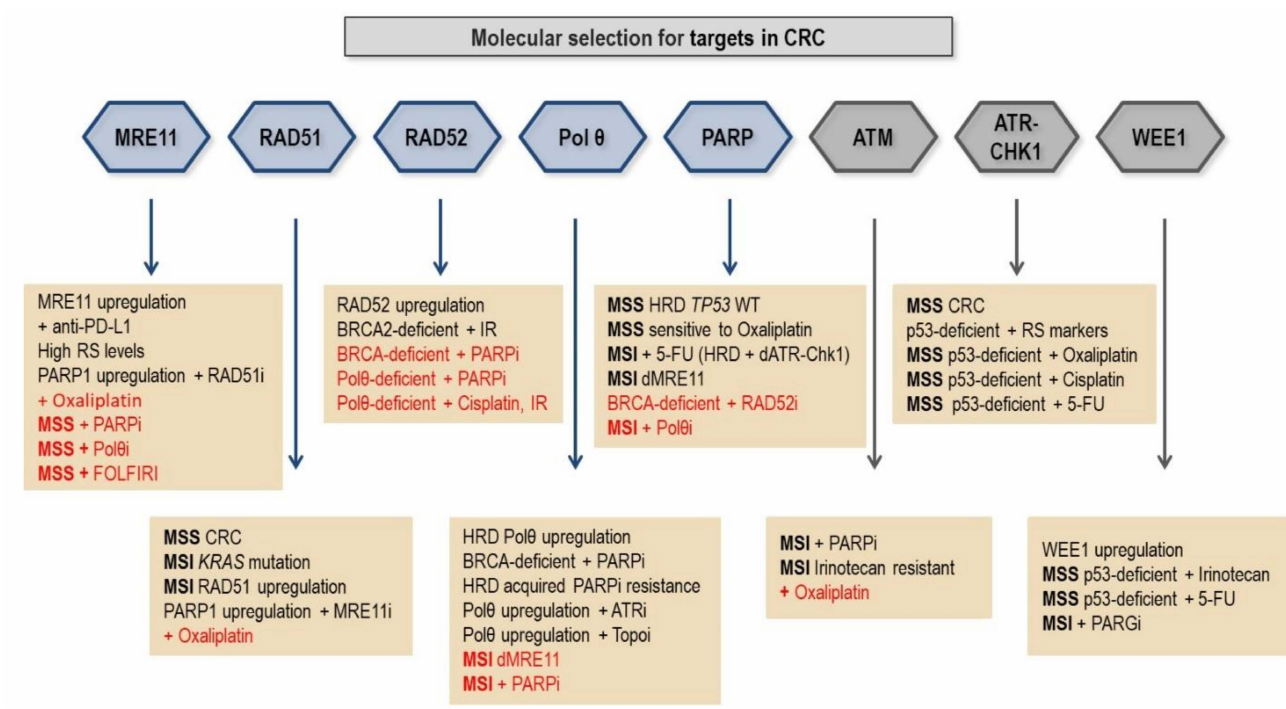
Figure 3. Possible targets for DDR inhibitors (repair proteins in blue and checkpoint kinases in grey) in CRC chemotherapy with supporting evidence in cancer cell lines and animal models, or candidates “to be tested” (in red), with estimated sensitivity based on results obtained in cells with deficiency of the respective target. HRD—homologous recombination deficiency, IR—ionizing radiation, Topoi—topoisomerase inhibitor, MMS—microsatellite stable, MSI—microsatellite in- stable, RS—replication stress, dATR-Chk1—deficient ATR-Chk1 signaling, FOLFIRI—folinic acid/fluorouracil/irinotecan chemotherapy